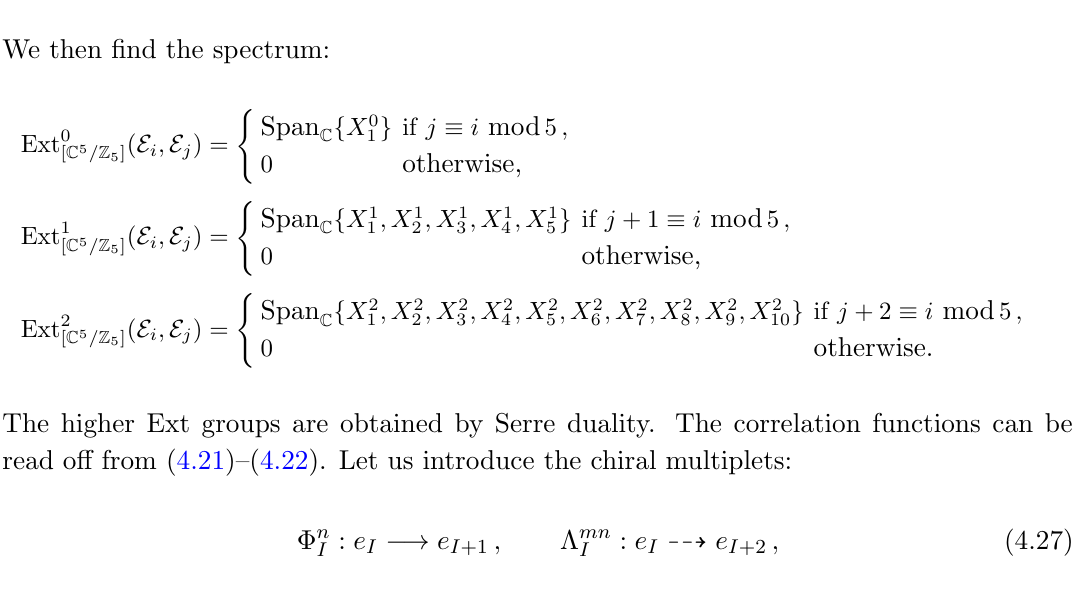
Figure 10 . Examples of 0d N = 1 quivers for orbifold singularities C 5 = (cid:0). The numbers on the chiral and fermi multiplet arrows indicate their